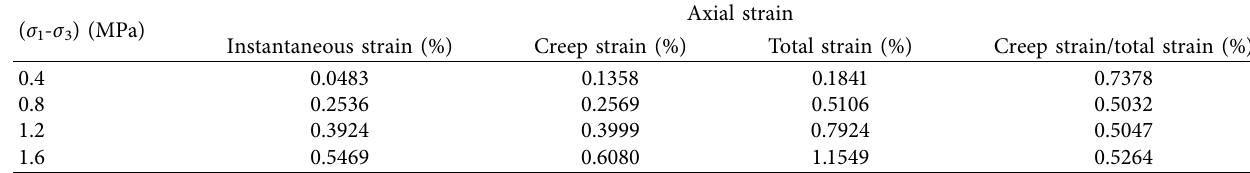
Table 2: Axial instantaneous strain, creep strain, and total strain of rock under various stress levels. ( σ 1 - σ 3 ) (MPa)